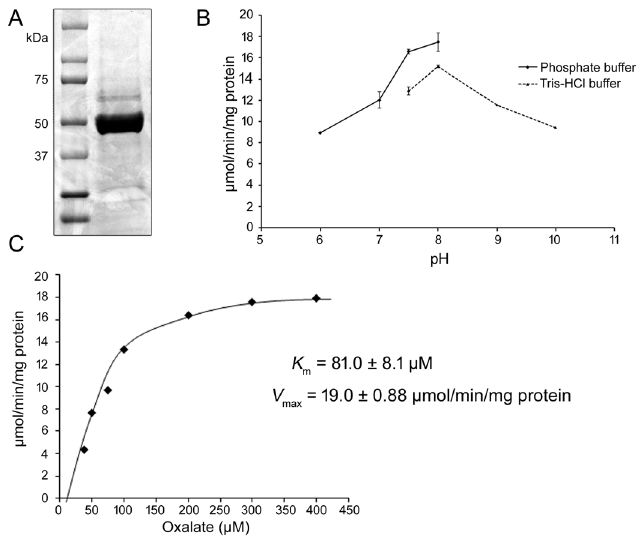
Fig 1. Biochemical Analysis of Mt AAE3. (A) SDS-PAGE gel of nickel-affinity purified His- Mt AAE3 protein (right) and molecular weight markers (left). (B) Optimum pH for Mt AAE3 was performed with 300 μ M oxalate using two buffer systems; potassium phosphate pH 6 – 8 and Tris-HCl pH 7.5 – 10. (C) Kinetic analysis of Mt AAE3 using a range of oxalate concentrations. K m and V max were determined from non-linear regression to the Michaelis-Menten equation for concentrations up to 400 μ M oxalate.